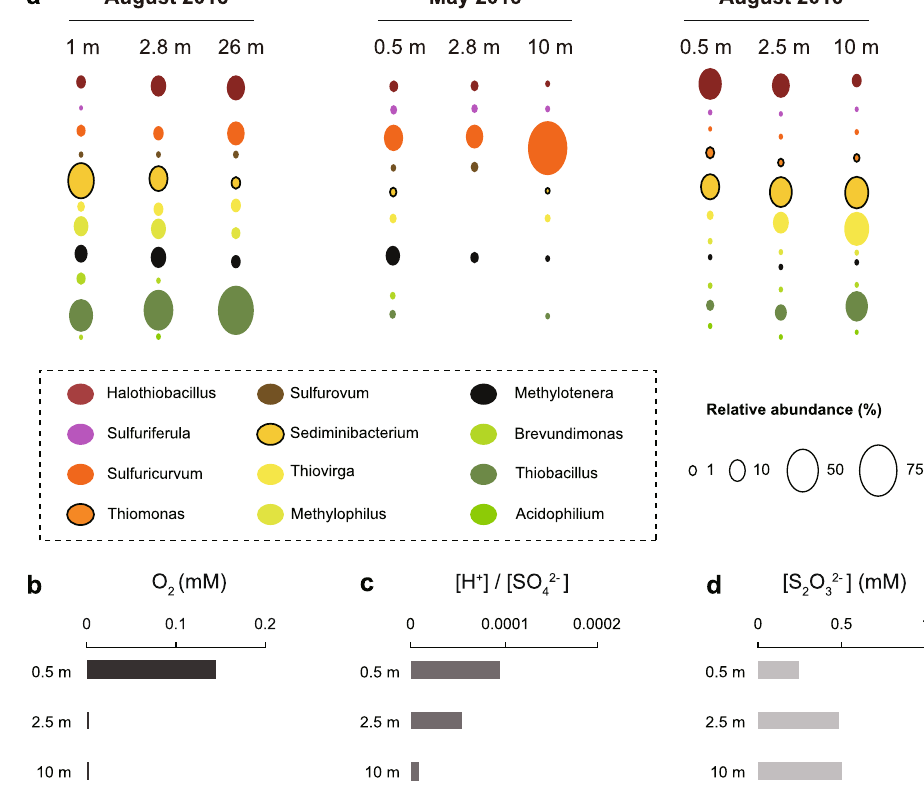
Fig. 3 | Oxic, hypoxic and anoxic zonations of SOB communities, their respective gene based sulfur oxidative and TEA reduction strategies and aqueous geochemical outcomes. a SOB relative abundances in August 2015, May 2018 and August 2018 through depth. b August 2018 dissolved oxygen